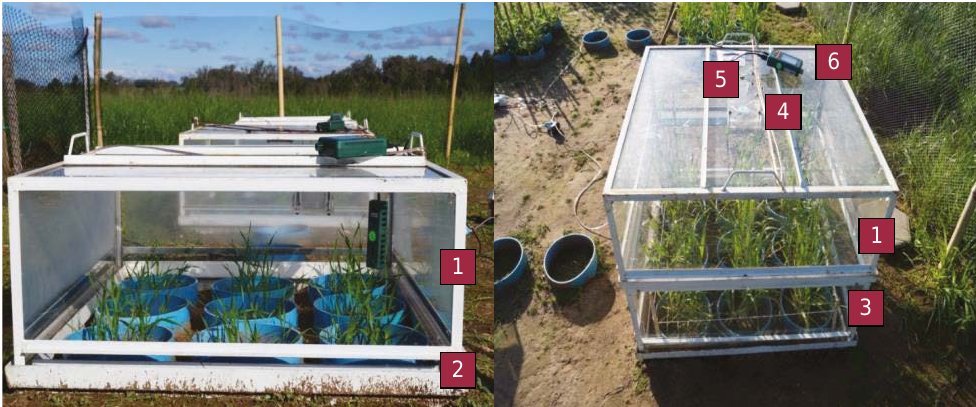
Figure 1. Labeling chamber used for in situ 13 C pulse labeling. Components are: (1) labeling chamber, (2) galvanized steel base, (3) chamber extension, (4) fan, (5) rubber septum and plastic container (inside) for 13 CO 2 production, and (6)